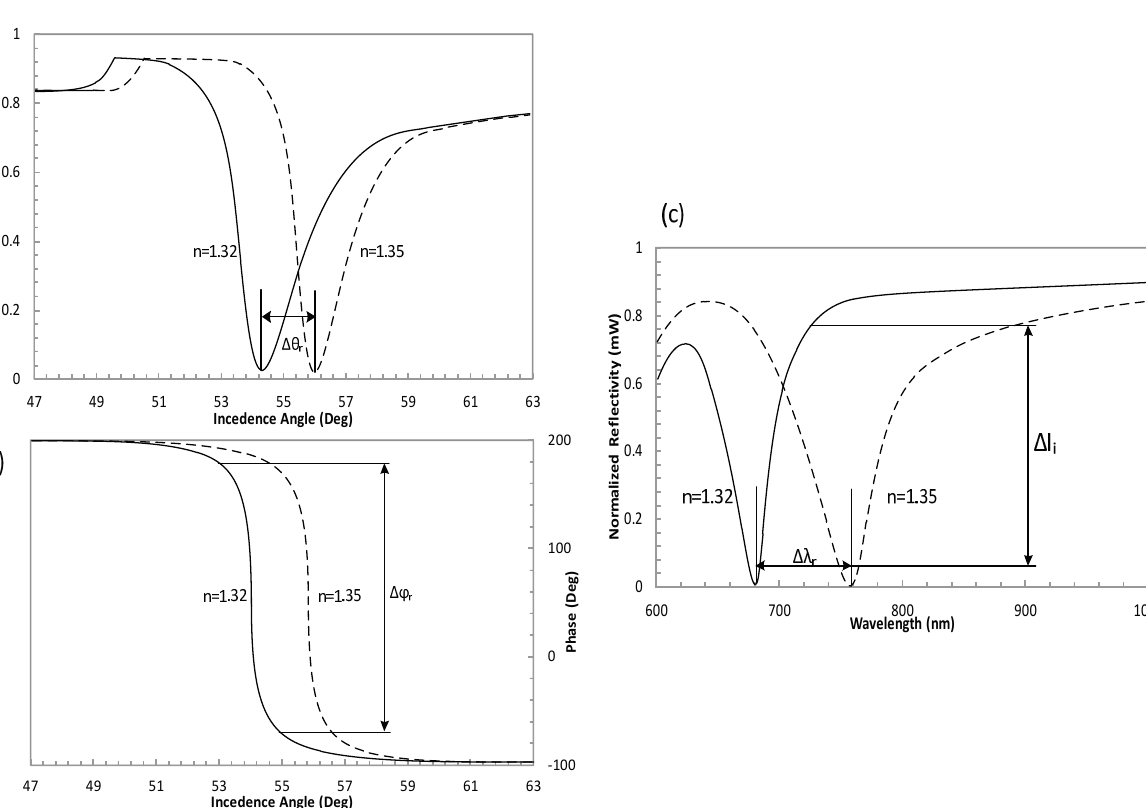
Figure 9. Light wave excitation of the SPW at the wavelength of 682 nm for reflectivity and phase in the Kretschmann configuration with respect to ( a ) an incidence angle of two different dielectrics; ( b ) a phase change of two different dielectrics; ( c ) the wavelength for two different dielectrics (angle of incidence =